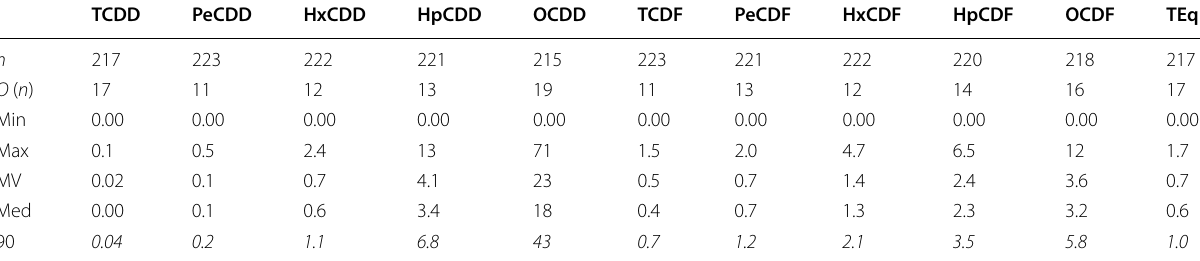
O ( n ), number of outliers; MV, mean value; Med, median; 90, 90%